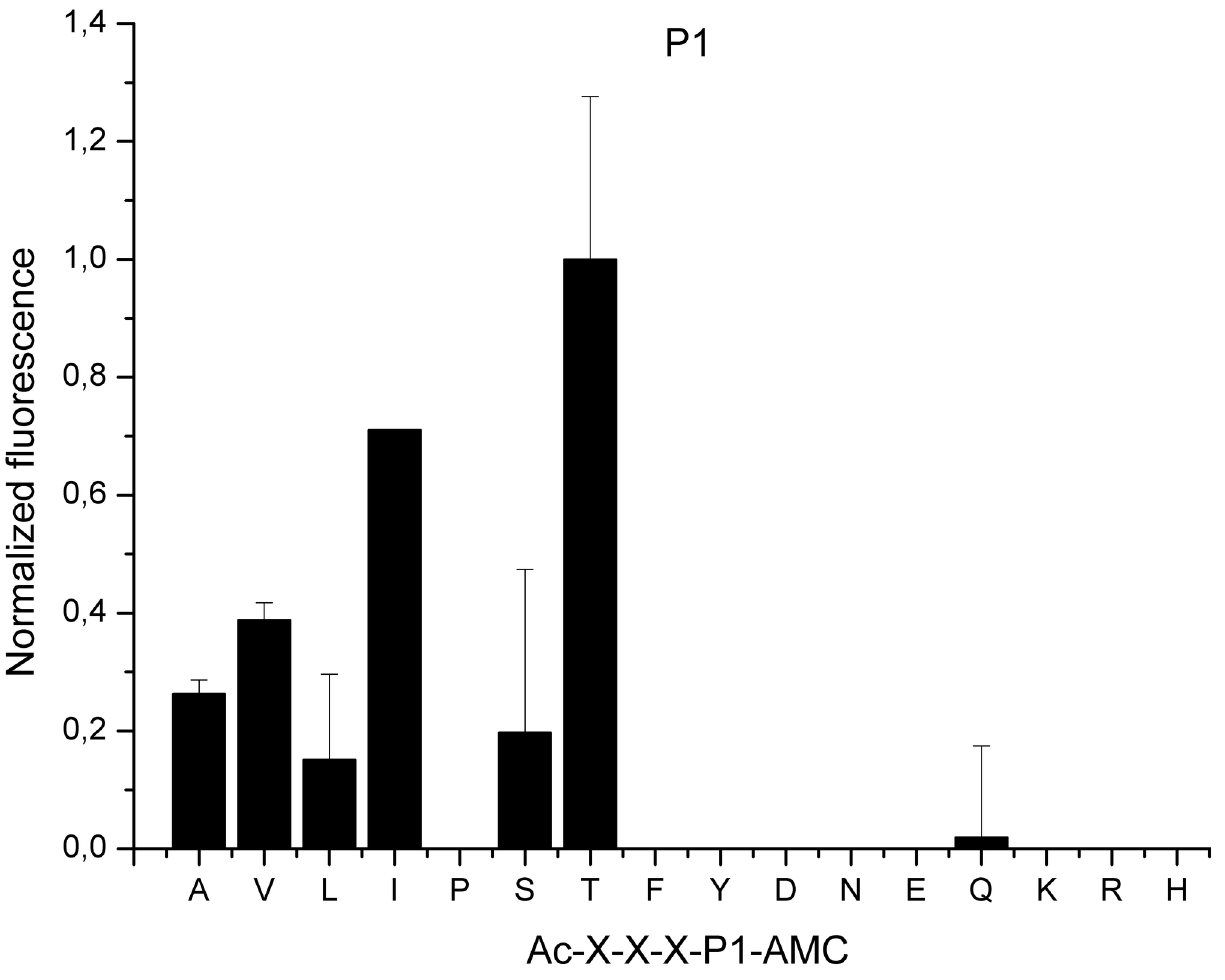
Figure 2. Substrate specificity of the SplD protease at the P1 subsite. Substrate preference of SplD at P1 subsite was determined using a positional scanning synthetic combinatorial library (PS-SCL) of a general structure Ac-P4-P3-P2-P1-AMC as described in Materials and Methods. Vertical bars indicate the activity of the enzyme against each tested sub-library (fluorescence of released AMC) normalized to the most active sub-library. Residues fixed at P1 subsite are indicated with the single-letter amino acid code. X indicates randomized substrate